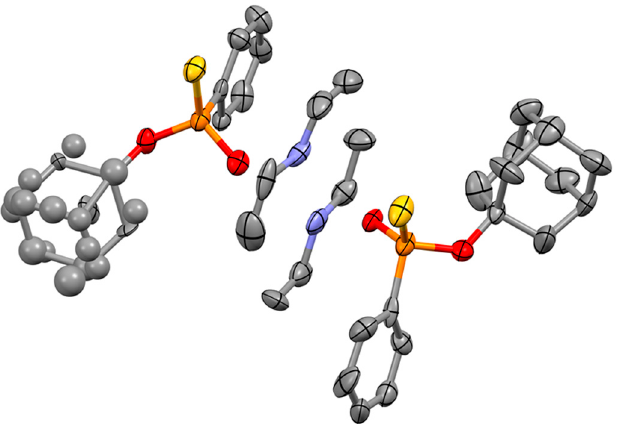
Figure 1. The crystallographically independent molecules in the asymmetric unit of the crystal without the atomic labelling. Hydrogens were omitted for clarity as well. Displacement ellipsoids are drawn at the 30% probability level for clarity.